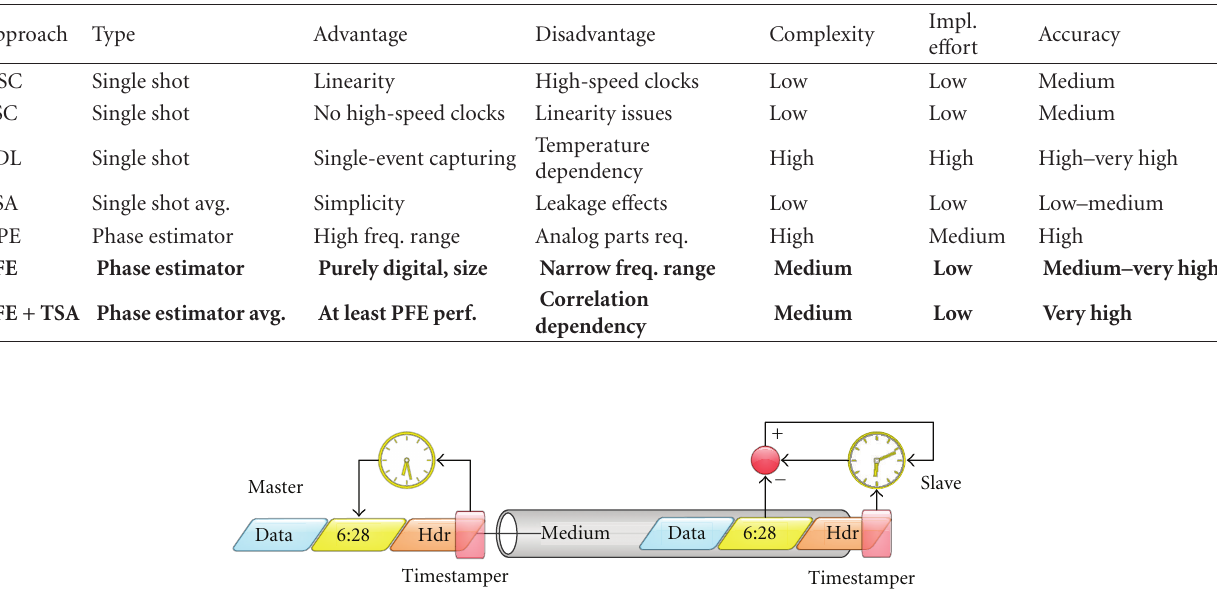
Figure 2: Basic method for clock synchronization in packet-based networks and the necessity of event detection